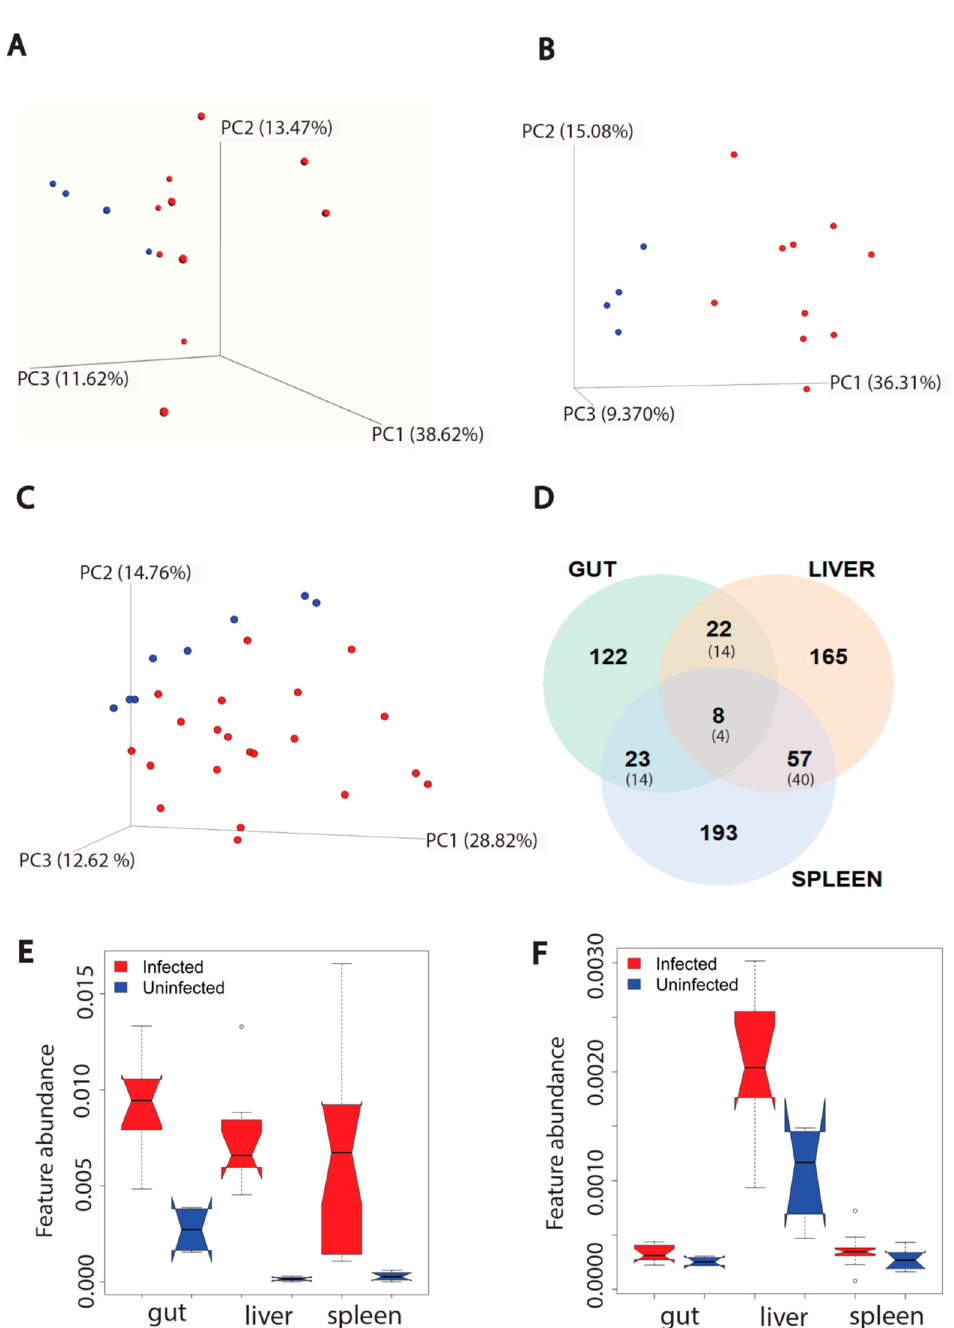
Figure 1. Effect of L. donovani infection on overall metabolism of host organs (gut ( n = 4 uninfected and n = 10 infected), liver ( n = 4 uninfected and n = 10 infected), spleen ( n = 8 uninfected and n = 21 infected, two samples per animal)) in positive mode. ( A ) PCoA analysis of extracted metabolites from infected and uninfected gut samples (PERMANOVA R 2 = 0.134, p -value > 0.05). Each sphere represented one sample. Red color represented infected samples and blue color, uninfected samples. ( B ) PCoA analysis of extracted metabolites from infected and uninfected liver samples (PER- MANOVA R 2 = 0.309, p -value < 0.01). ( C ) PCoA analysis of extracted metabolites from infected and infected spleen samples (PERMANOVA R 2 = 0.137, p -value < 0.01). ( D ) Venn diagram representing the number of metabolites perturbed by infection at each organ. Smaller font numbers in parenthe- ses show the number of metabolites commonly perturbed between indicated organs and that have the same direction of change in response to infection. ( E ) Kynurenine metabolite increased by infec- tion in three organs. *, Wilcoxon rank-sum test with FDR correction, p -value < 0.01. ( F ) Riboflavin